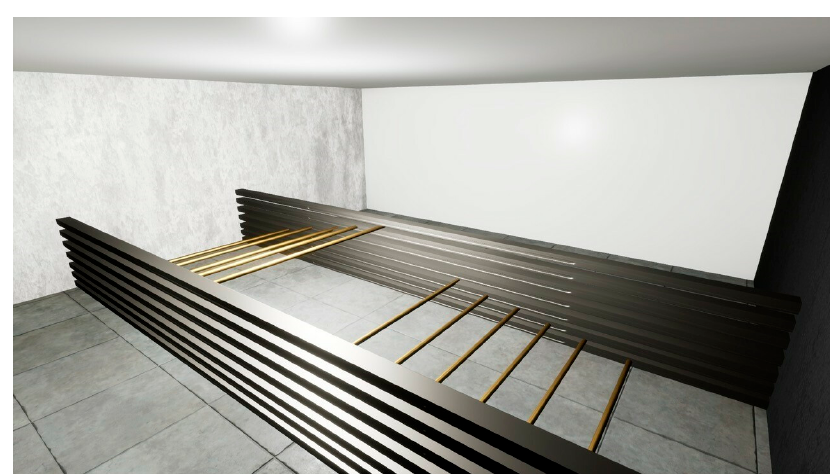
Figure 6. Room no. 3 designed for static and dynamic balance exercises.